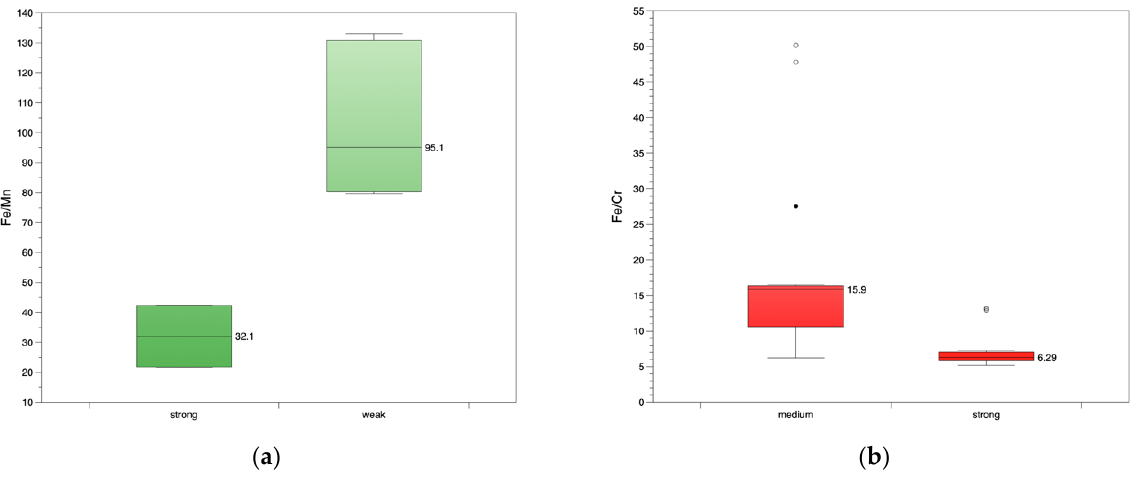
Figure 19. ( a ) The Fe/Mn ratio affects the intensity of green fluorescence. The higher the Fe/Mn ratio, the lower the intensity. ( b ) The negative relationship of Fe/Cr ratio and the intensity of red fluorescence. The values in the figure are the average value of each group.